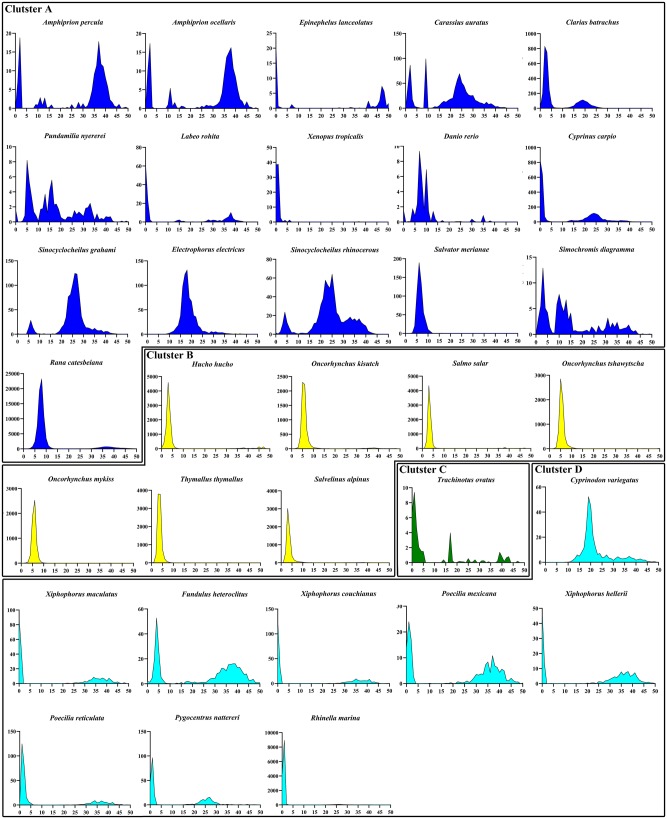
—Evolutionary dynamics of TRs in vertebrates. RepeatMasker utility scripts were used to calculate the K divergence from consensus sequences or the representative sequence (Tarailo-Graovac and Chen 2009). Species with less than ten copies of TRs in their genomes were excluded from the analysis. The y axis represents the coverage (kb) of each TR element in the genome and the x axis indicates the Kimura divergence estimate.